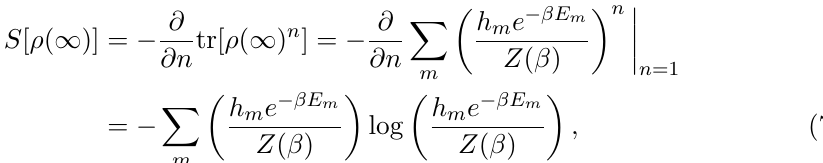
Figure 2. Decoherence of two-dimensional Dirac fermions. (a) Periodicity of the function f ( (cid:12); y ) as a function of the time of evolution t . (b) Time evolution of the purity for a thermo(cid:12)eld dou- ble state prepared at t = 0 under decoherence, when the evolution is governed by the master equation (2.3). The asymptotic value of the purity exceeds the value Z (2 (cid:12) ) =Z ( (cid:12) ) 2 , indicating the presence of degeneracies in the energy spectrum. Cases with (cid:12) = 1 = 2 ; 1 with corresponding values Z (2 (cid:12) ) =Z ( (cid:12) ) 2 = 0 : 243 ; 0 : 718 are shown in red and blue color, respectively. where (cid:21) are the eigenvalues of (cid:26) ( 1 ). The corresponding von Neumann m